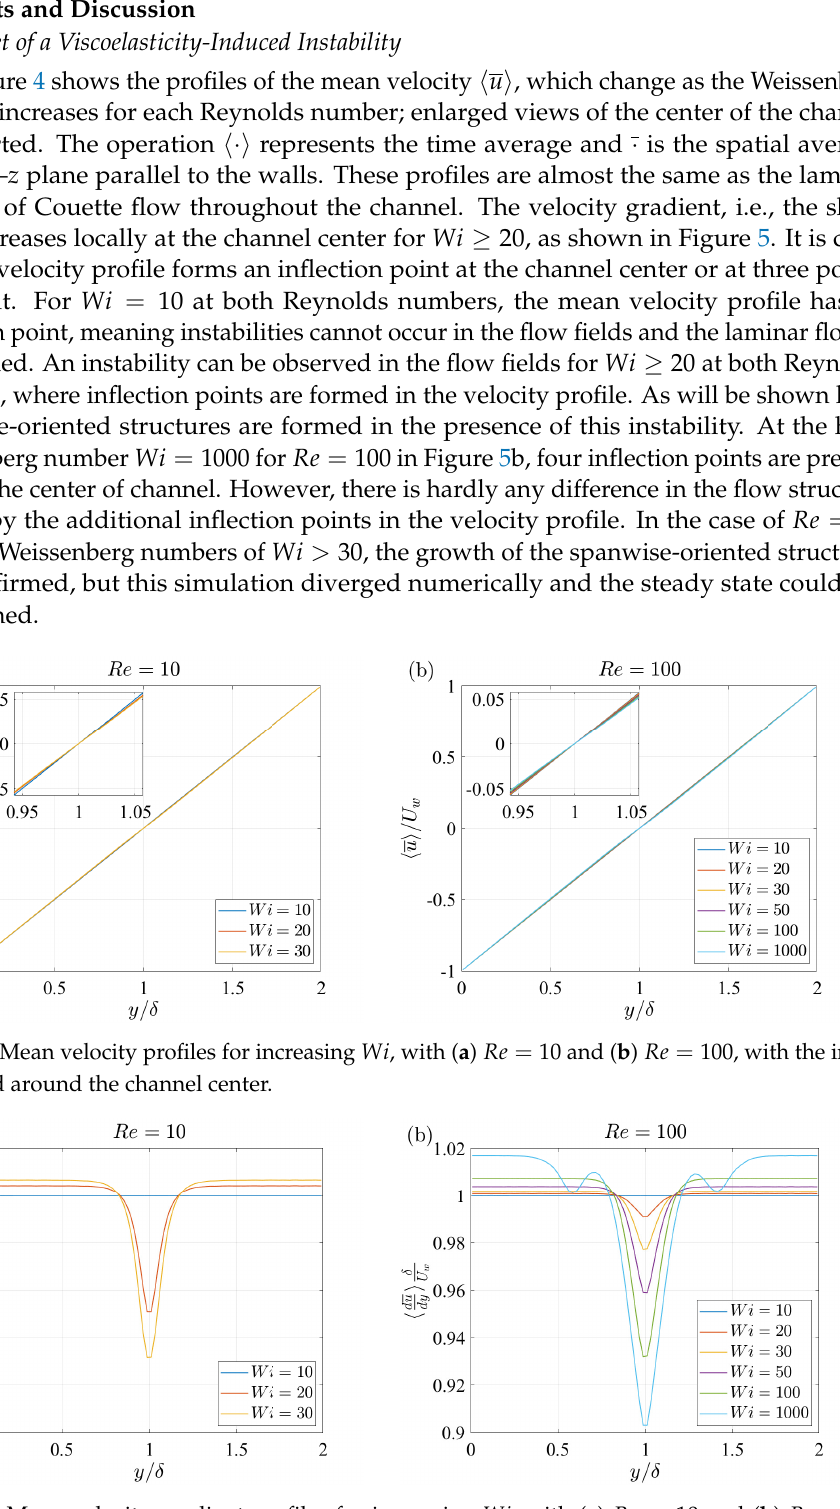
Figure 5. Mean velocity gradient profiles for increasing Wi , with ( a ) Re = 10 and ( b ) Re = 100 corresponding to the mean velocity profiles in Figure